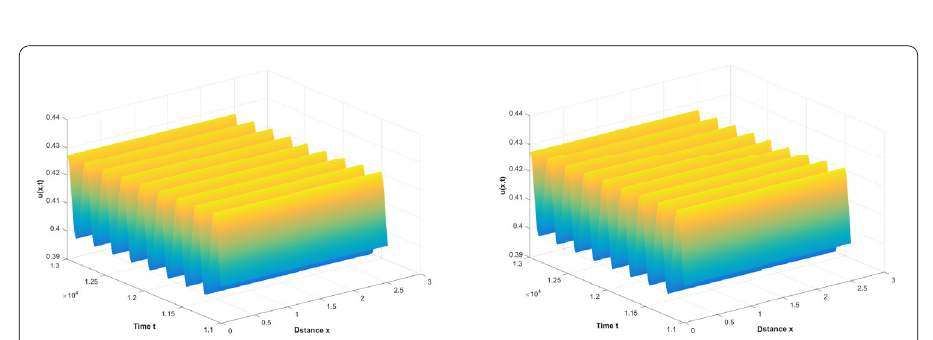
Figure 3 Numerical simulations for prey population with β = 0.18 τ = 22. (Left: model (1.4). Right: model (2.9))